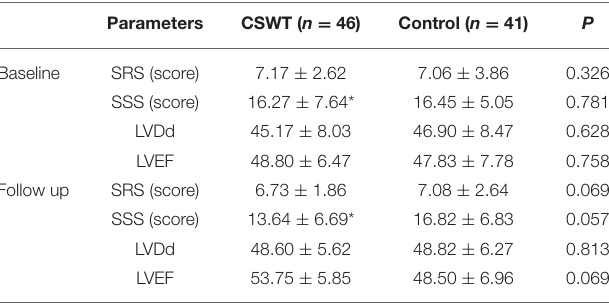
Frontiers in Cardiovascular Medicine |